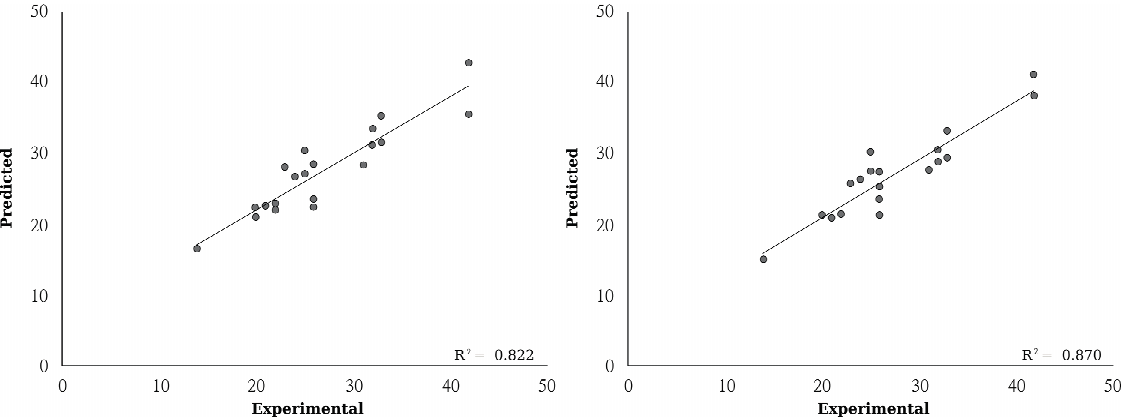
Figure 3. Relationship between predicted and experimental radical scavenging